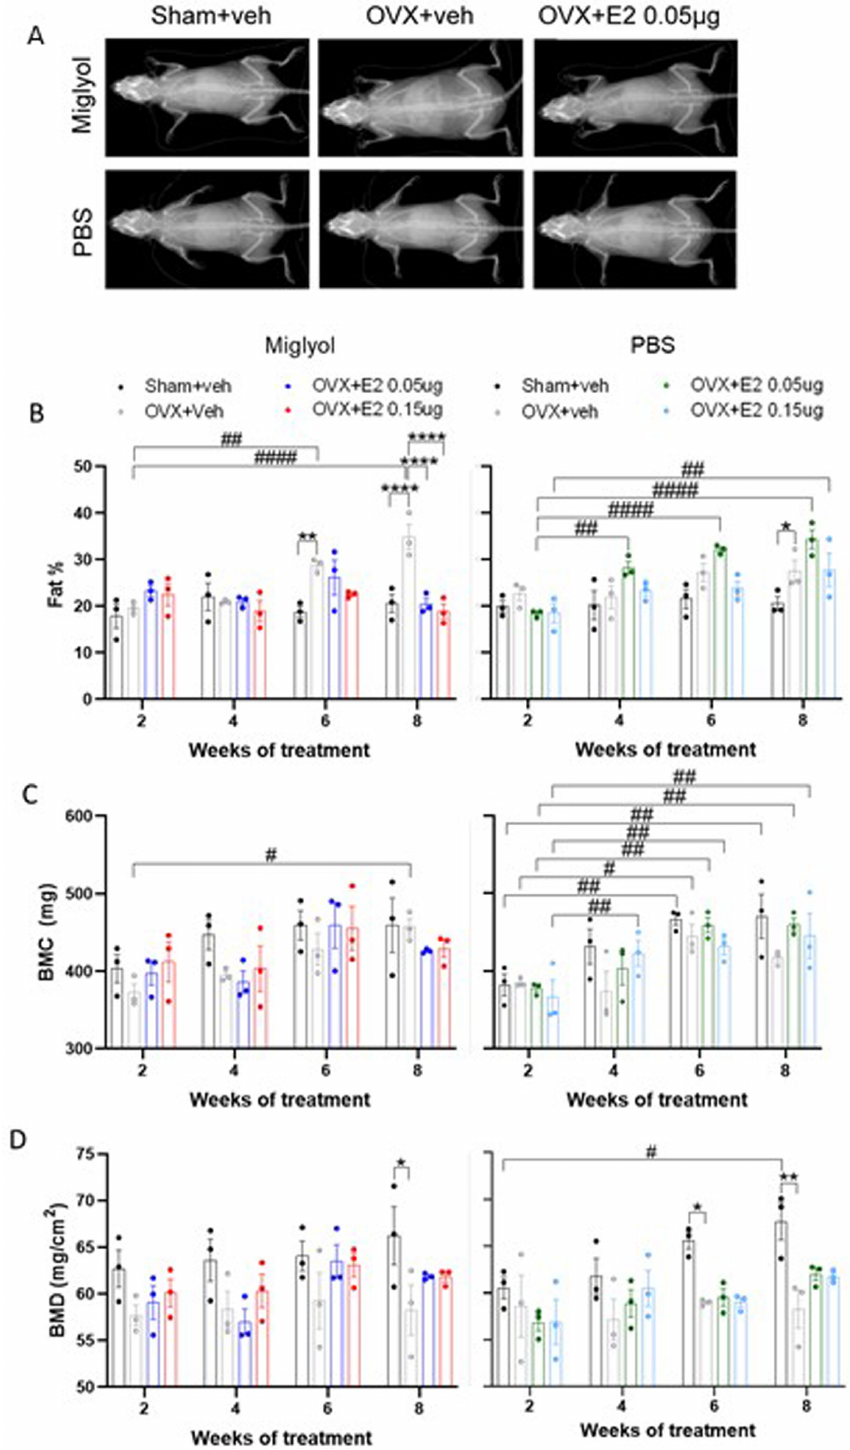
Figure 6. Analysis of body composition by DXA. Mice were subjected to Sham or OVX surgery and treated with s.c. injections of vehicle (miglyol or PBS) or 17β-estradiol (E2; 0.05 µg/mouse or 0.15 µg/mouse) every 4 days. The analyses were performed using a dual energy x-ray absorptiometry (DXA) scanner before sacrifice after 2, 4, 6 and 8 weeks of treatment. Representative DXA scan images for the experimental groups after 8 weeks of treatment ( A ). Percentage of fat ( B ), bone mineral content (BMC; C ) and bone mineral density (BMD; D ) were determined for the whole body. Data are expressed as mean±SEM; n=3 for each experimental group. * statistical differences between sham+veh vs OVX+veh; or OVX+veh vs the E2 treatment groups; # statistical difference vs week 2 of the same treatment group. *or #, p<0.05; **or ##, p<0.01; ***or ###, p<0.001; ***** or ####, p<0.0001; Two-way ANOVA followed by Dunnet’s post-hoc test).